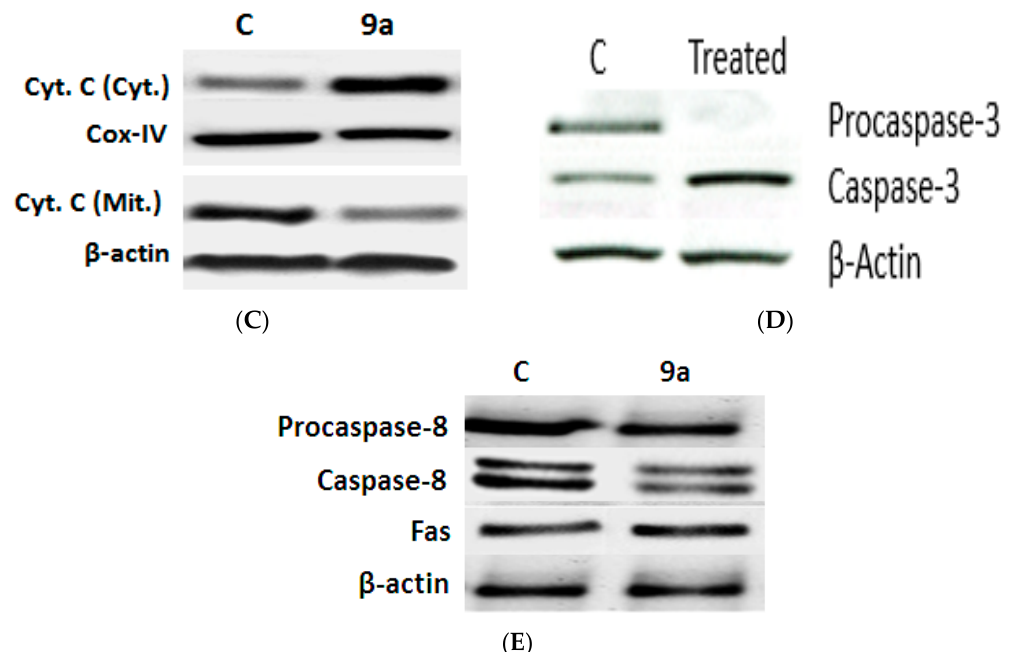
Figure 5. Compound 9a -modulated apoptotic and survival signaling in MCF-7 cells. ( A ) Compound 9a up-regulated p53, p21 and Bax. Cells were treated with 2 μ M of 9a for 24 h. The MCF-7 cell lysates were collected and the expression of p53, p21 and Bax was studied by western blot analysis using specific antibodies in treated and non-treated control cells. β -actin was used as a loading control; ( B ) Compound 9a down-regulates Bcl-2, MDM-2 and Akt levels in MCF-7 cells. Cells were treated with 2 μ M 9a for 24 h. The cell lysates were collected and the expression of Bcl-2, MDM-2 and AKT was studied by western blot analysis using specific antibodies in treated and non-treated control cells. β -actin was used as a loading control; ( C ) Total proteins in cytosol and mitochondrial fraction were extracted and western blotting analysis was applied to determine the protein levels of cytochrome c in treated and non-treated cells; ( D ) Compound 9a up-regulates the level of caspase-3 in MCF-7 Cells. Cells were treated with 2 μ M 9a for 24 h, cells were lysed and total protein was collected and subjected to western blot analysis to determine pro-caspase and caspase-3 proteins expression levels in treated and non-treated control cells. β -actin was used as a loading control; ( E ) The cell lysates were collected and the expression levels of FAS, procaspase-8 and caspase-8 was studied by western blotting analysis using specific antibodies, β -actin was used as loading control.